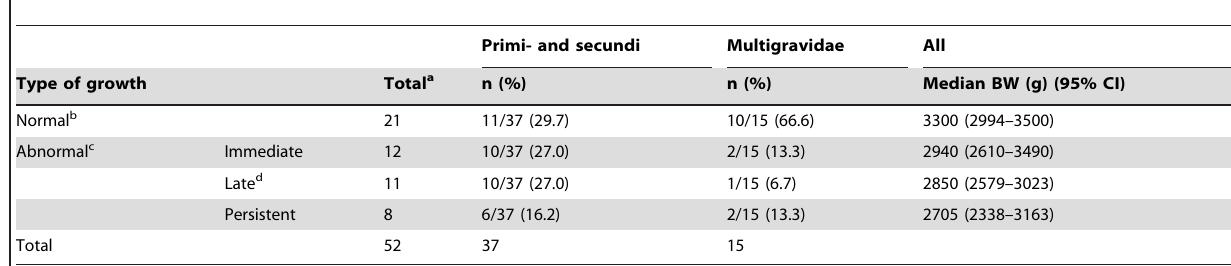
Table 6. Patterns of fetal growth following a malaria infection evaluated using D z for the individual